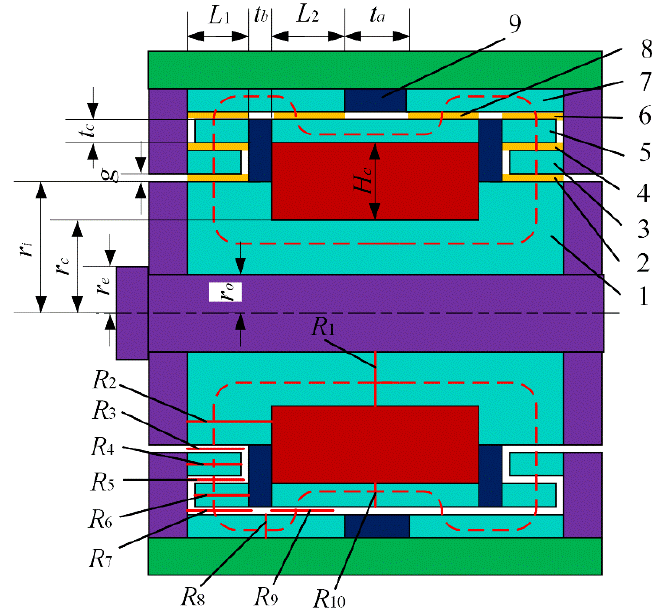
Figure 3. Simplified magnetic circuit of the proposed MR damper. 1. Magnetic core, 2. Inner gap, 3. Inner magnetic sleeve, 4. Middle gap, 5. Middle magnetic sleeve, 6. First outer gap, 7. Outer magnetic sleeve, 8. Second outer gap, 9. Non-magnetic ring.